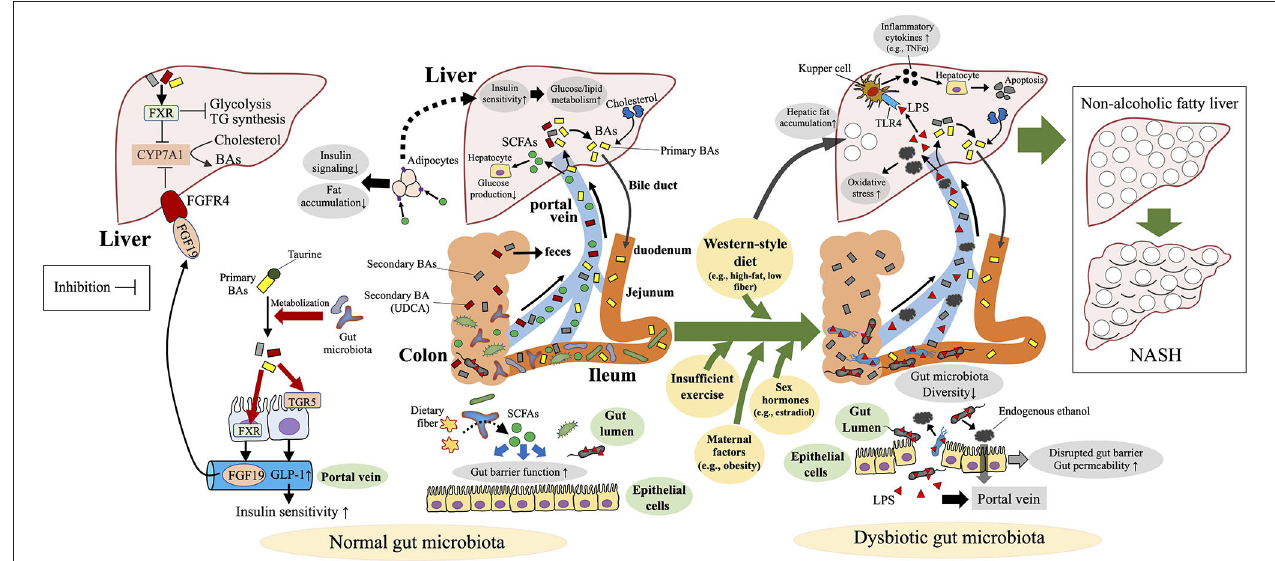
FIGURE 3 | Mechanisms of dysbiosis-induced NAFLD in children and adolescents. Dysbiosis and disruption of the gut microbiota contribute to the development of non-alcoholic fatty liver disease (NAFLD) via modulation of the gut–liver homeostasis, including the involvement of the gut barrier, bacterial endotoxin [lipopolysaccharide (LPS)], endogenous ethanol, bile acids (BAs), and short-chain fatty acids (SCFAs). FGFR4, fibroblast growth factor receptor 4; FXR, farnesoid X receptor; TGR5, G-protein-coupled bile acid receptor; TLR4, toll-like receptor 4; TNF- α , tumor necrosis factor- α ; UDCA, ursodeoxycholic